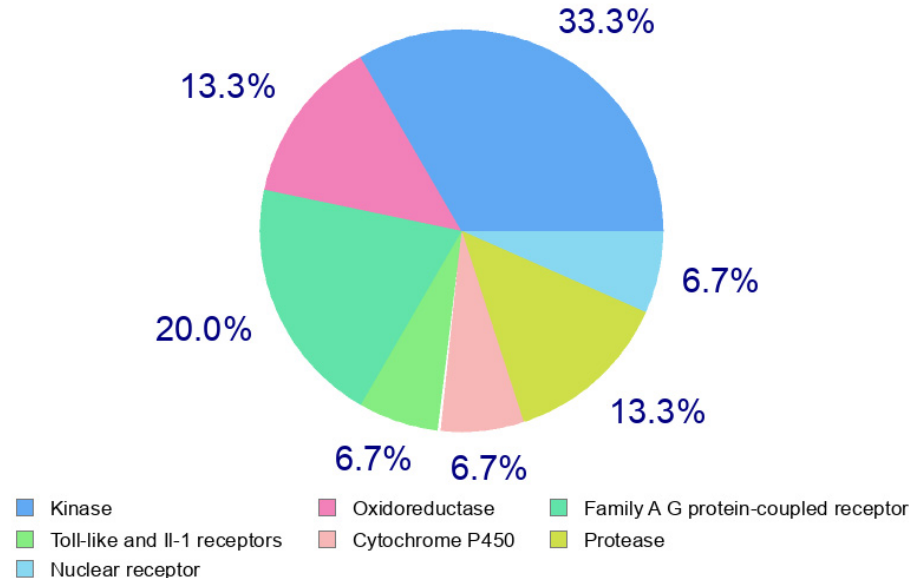
Figure 6. Target predication of compound 3b .